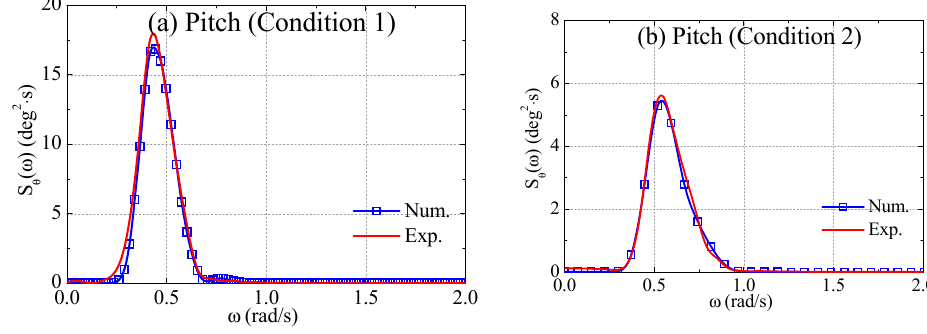
Figure 8. Comparison of heave spectra.